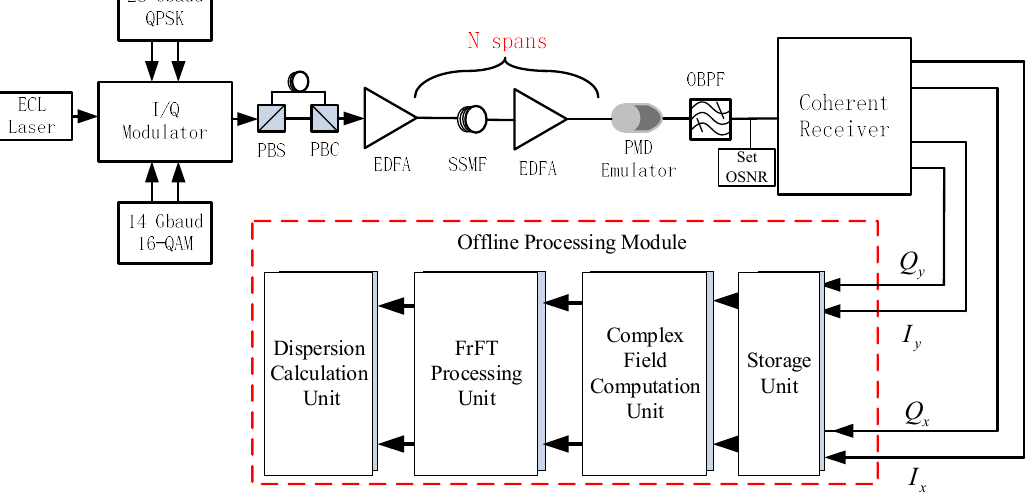
Figure 6. System simulation block diagram of the CD estimation method based on FrFT.